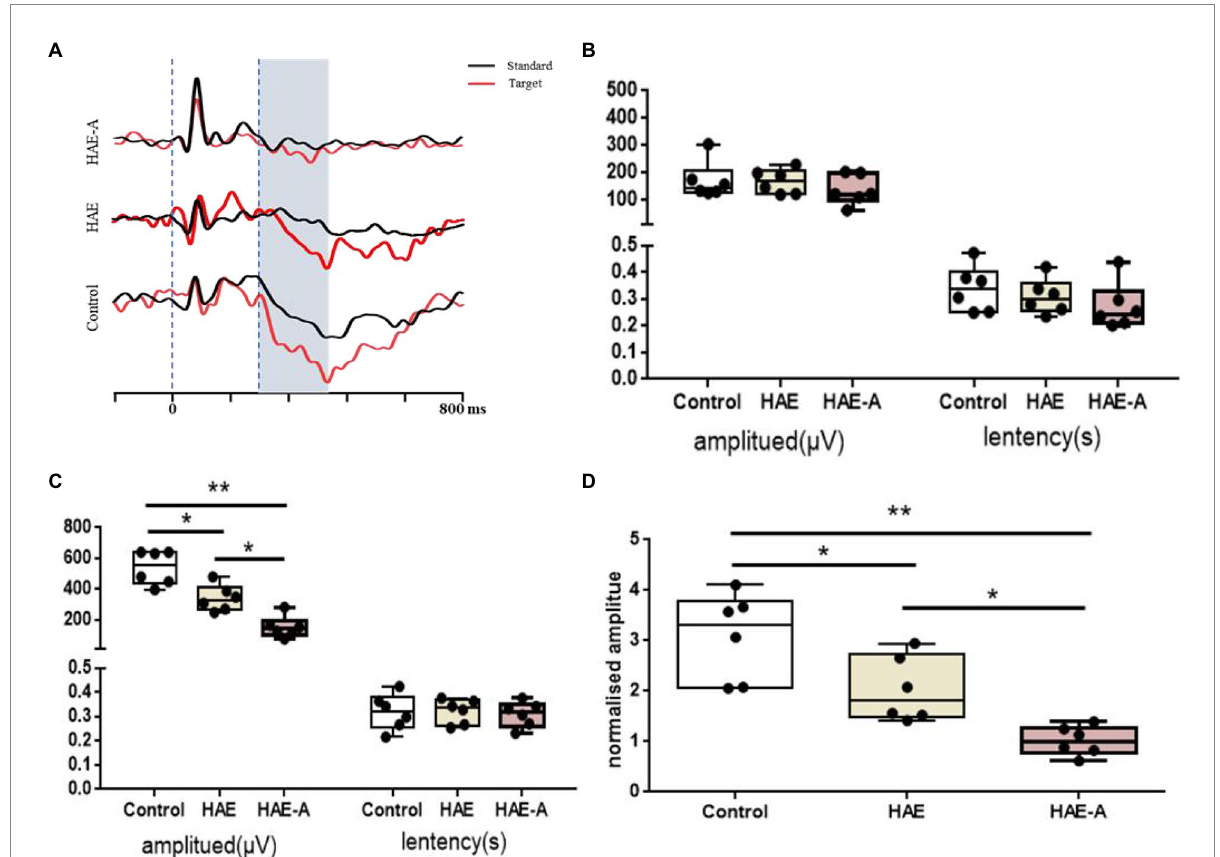
FIGURE 3 Variation of P300 of the oddball behavioral paradigm training test. (A) The profile of P300 in control, HAE and HAE-A group, respectively; (B) The result of P300 evoked by standard tone stimulation; (C) The result of P300 evoked by target tone stimulation; (D) The result of normalized P300 amplitude by target/standard. Data are presented with the means ± standard deviation ( n = 6). *Difference is significant at the 0.05 level ( p < 0.05); **difference is significant at the 0.01 level ( p <